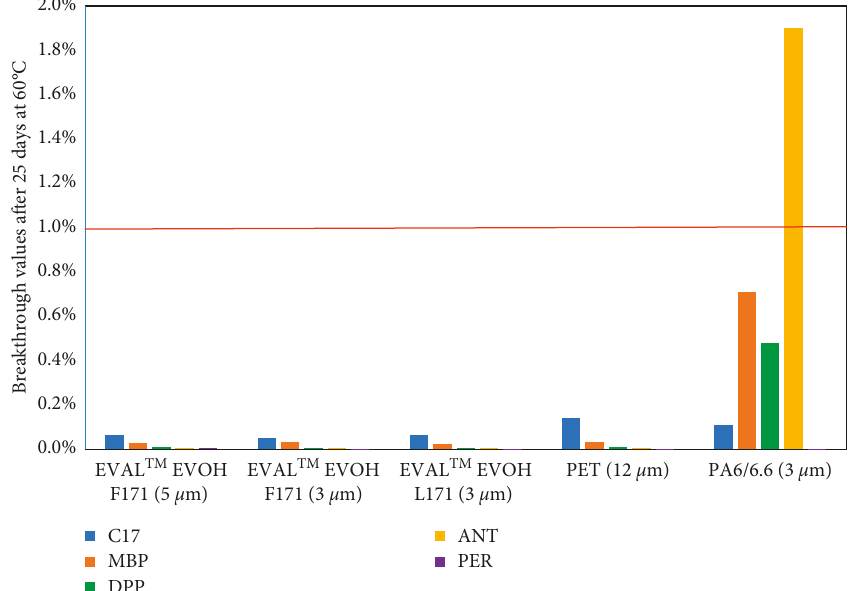
Figure 4: Breakthrough values of n -heptadecane (C17), 4-methyl benzophenone (MBP), di- n -propyl phthalate (DPP), anthracene (ANT), and perylene (PER) after 25 days at 60 °